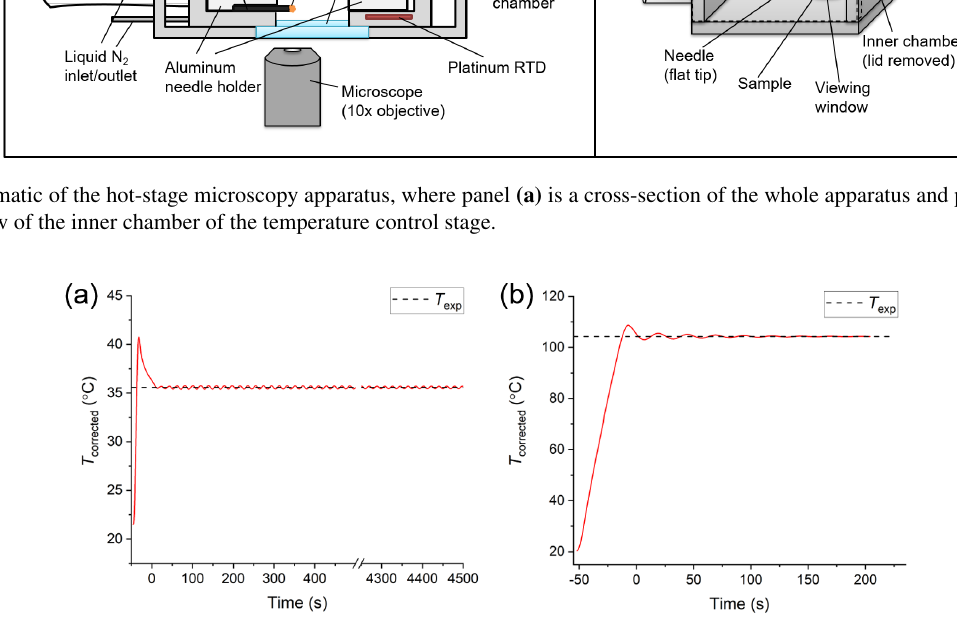
Figure 3. Temperature profiles from hot-stage microscopy experiments. Beginning at room temperature (prior to t = 0), the temperature ramps at ∼ 2 ◦ Cs − 1 to the experimental temperature ( T exp ; black dashed line). The start of the experiment ( t = 0) begins once the temperature oscillations about T exp are < 2 ◦ C. The profile in panel (a) is an example of the minimum temperature used (35.6 ◦ C) and in panel (b) is an example of the maximum (104.3 ◦